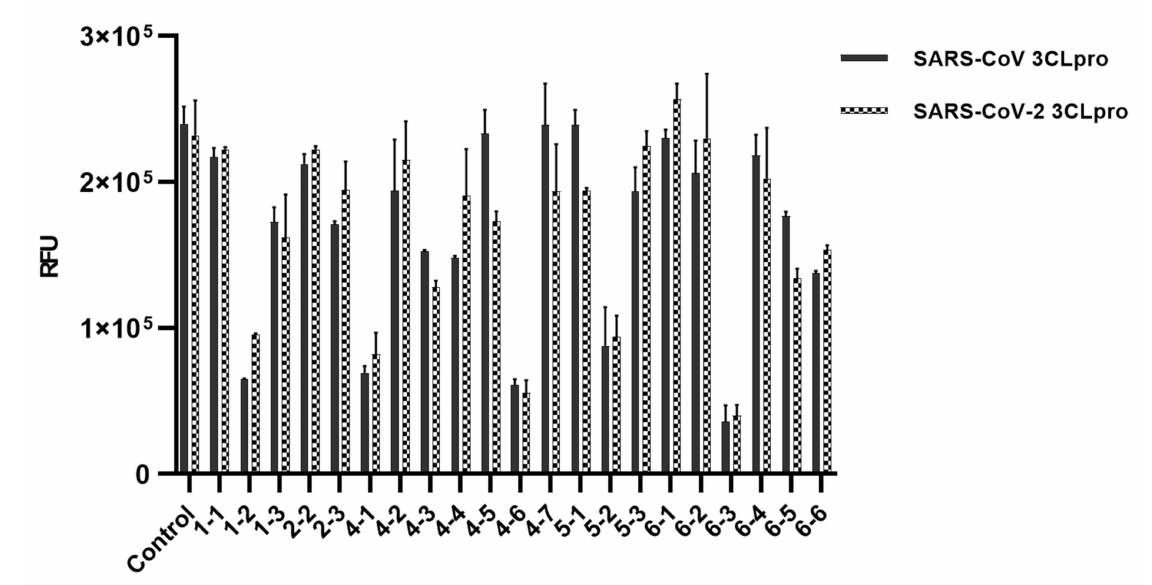
Figure 1. Inhibitory screening data of the chemical library against SARS-CoV and SARS-CoV-2 3CLpros. All chemical (40 µ M) were confirmed for their inhibitory potential through a comparison of actual absorbance with control at 490 nm. Three chemicals (Nos. 2-1, 3-1 and 5-4) were not plotted, due to the abnormal surge of Relative Fluorescence Units (RFU) after the proteolytic cleavage of the substrate. The RFU are plotted against the log-concentration of inhibitory compounds. Each dot is expressed as the mean ± standard error of the mean (n =